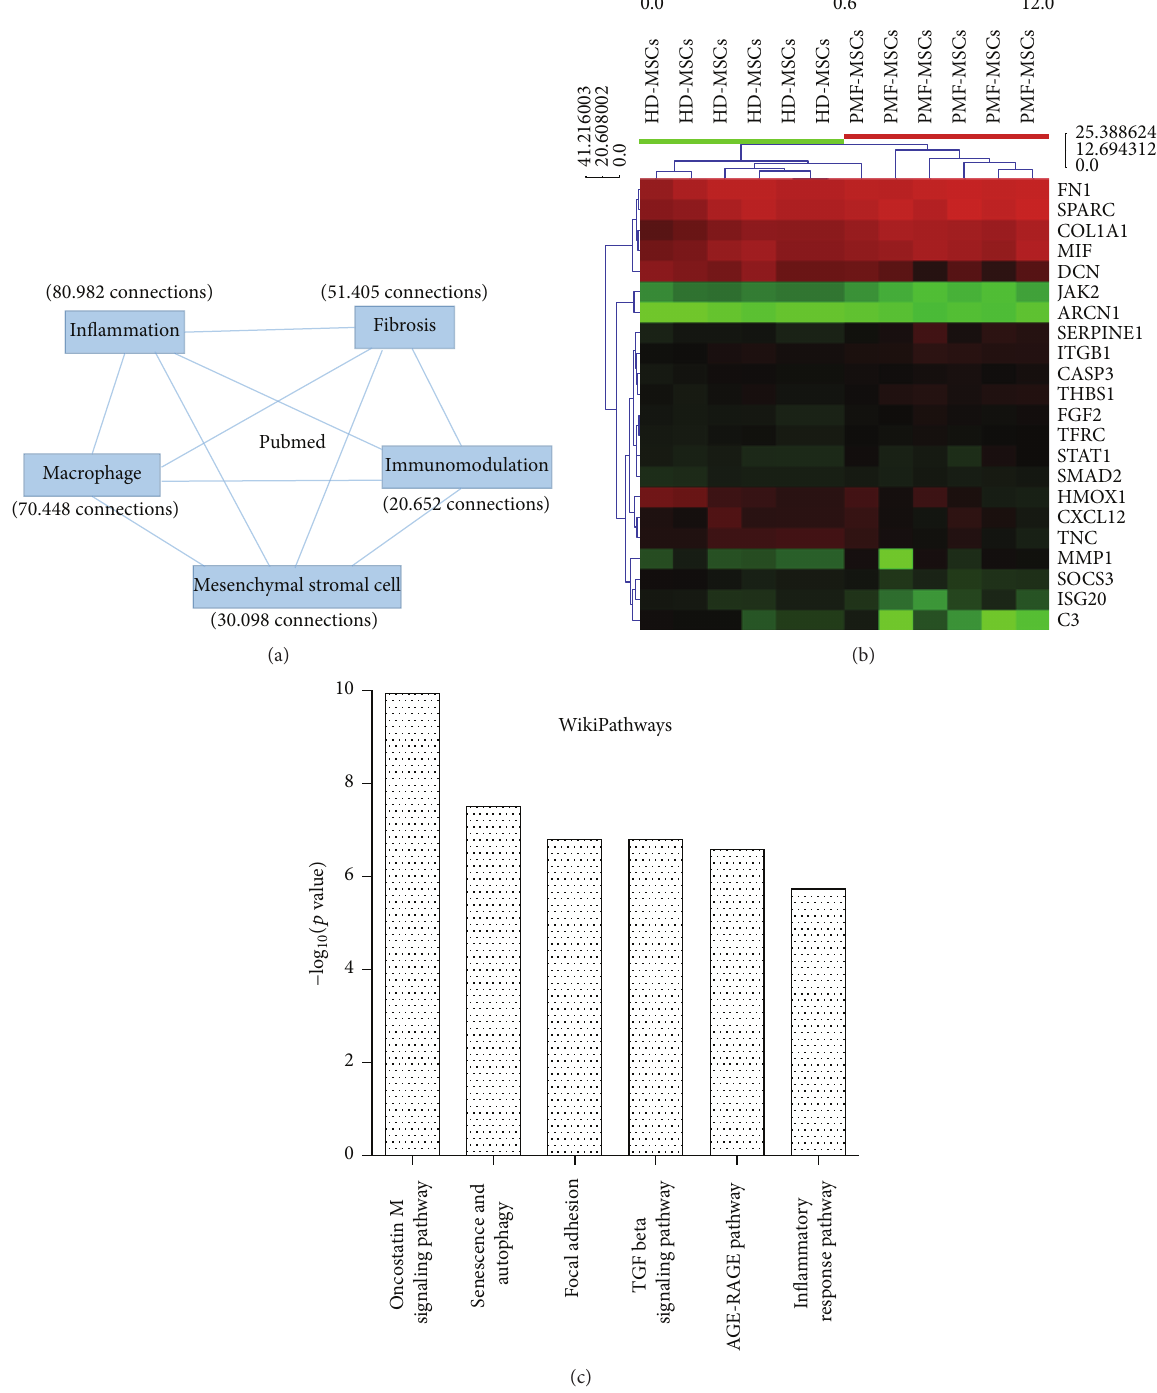
Figure 2: Data-mining prediction of inflammatory gene expression profile in BM-MSCs from PMF patients. (a) Keywords used during data- mining to link the scientific information between inflammation and altered niche in primary myelofibrosis; (b) unsupervised classification on data from inflammation prediction of gene expression profile from PMF BM-MSCs (transcriptome GSE44426); (c) functional enrichment on WikiPathway database for inflammation signature prediction of BM-MSCs from PMF